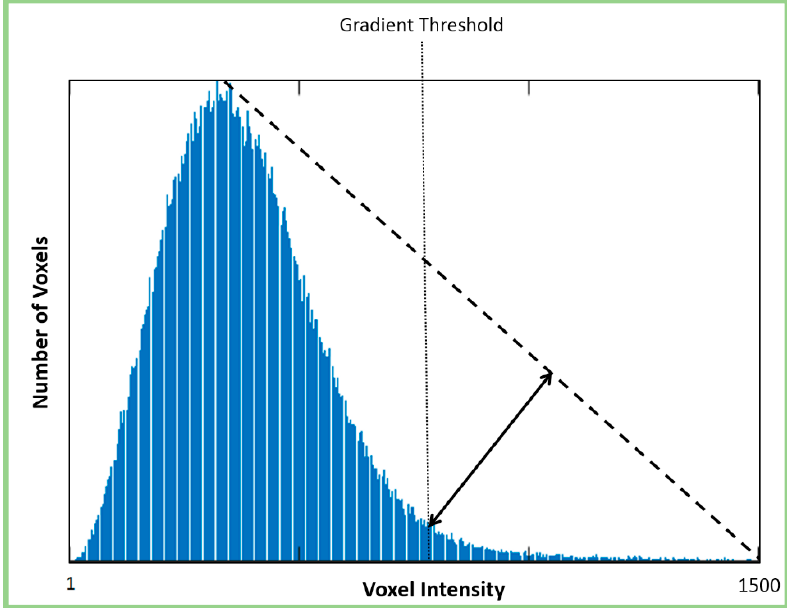
Figure 7. Automated gradient threshold selection using the triangle approach (based on figure in [10]).